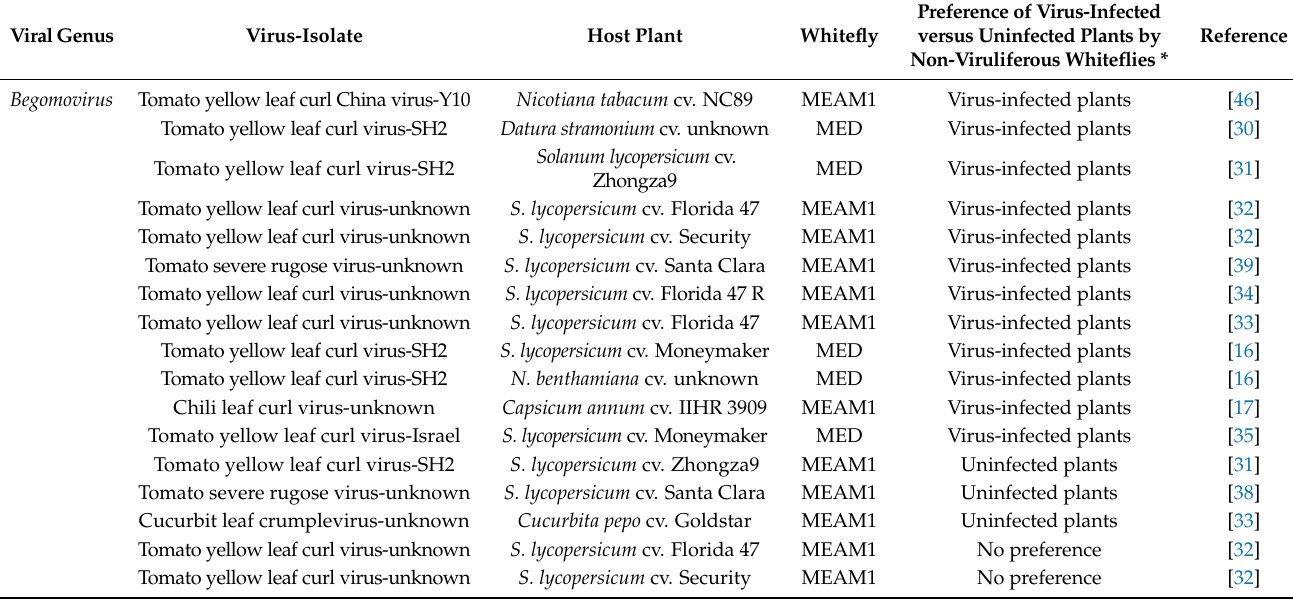
Table 1. Plant-mediated effects of virus infection on whitefly